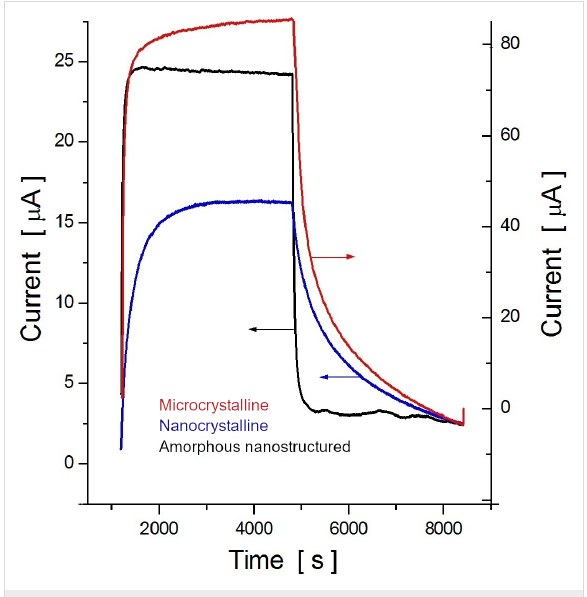
Figure 3: Normalized dynamic response of a microcrystalline (red), nanocrystalline (blue) and amorphous (black) nanostructured Te-based gas-sensitive device to a rectangular pulse of 1.0 ppm NO 2 at room temperature (22